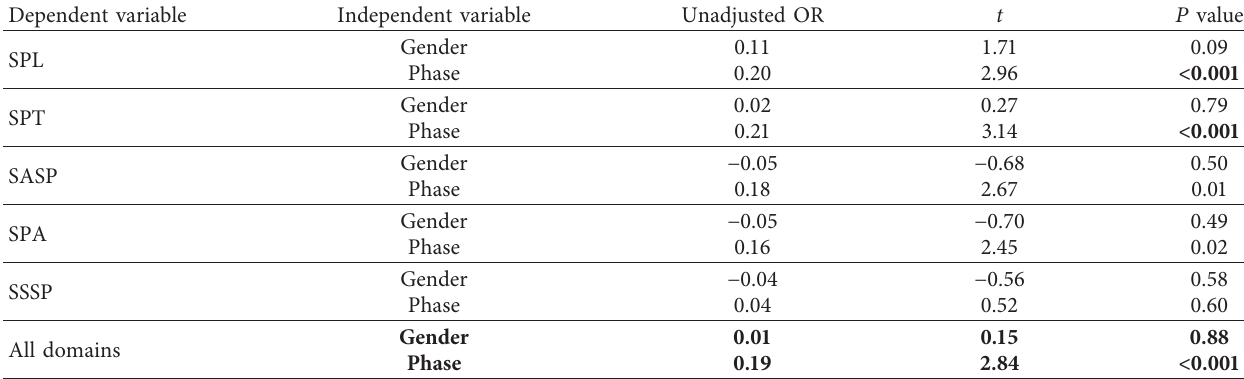
Table 7: Linear regression analysis of the domain scores with the gender and phase of